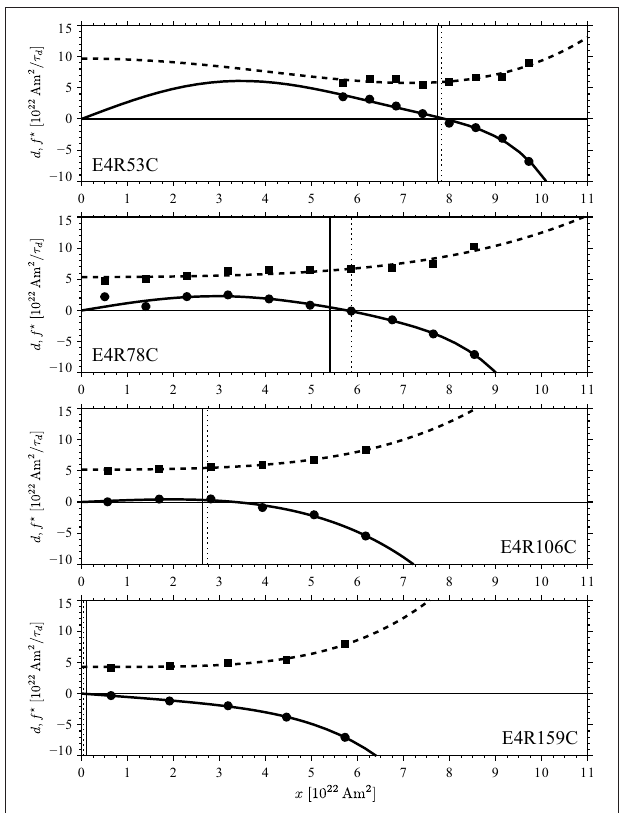
FIGURE 6 | Same as Figure 3 but for the palaeomagnetic (virtual) axial dipole moment variations from model PADM2M. Time is rescaled using an Earth’s core dipole decay time of τ d = 56